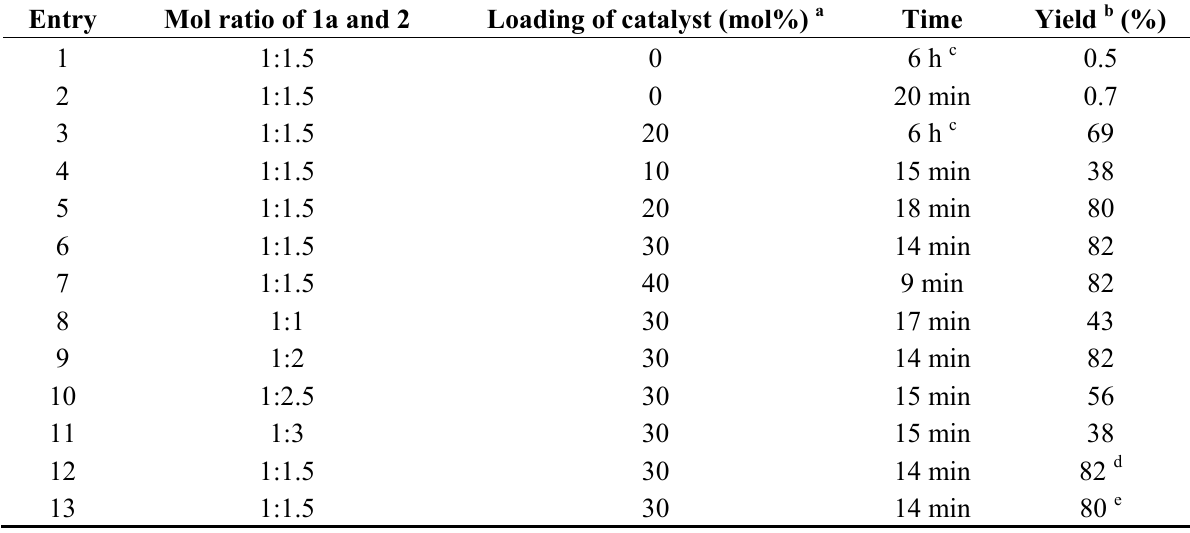
Table 1. Optimization for the synthesis of 2 H -chromene 3a a